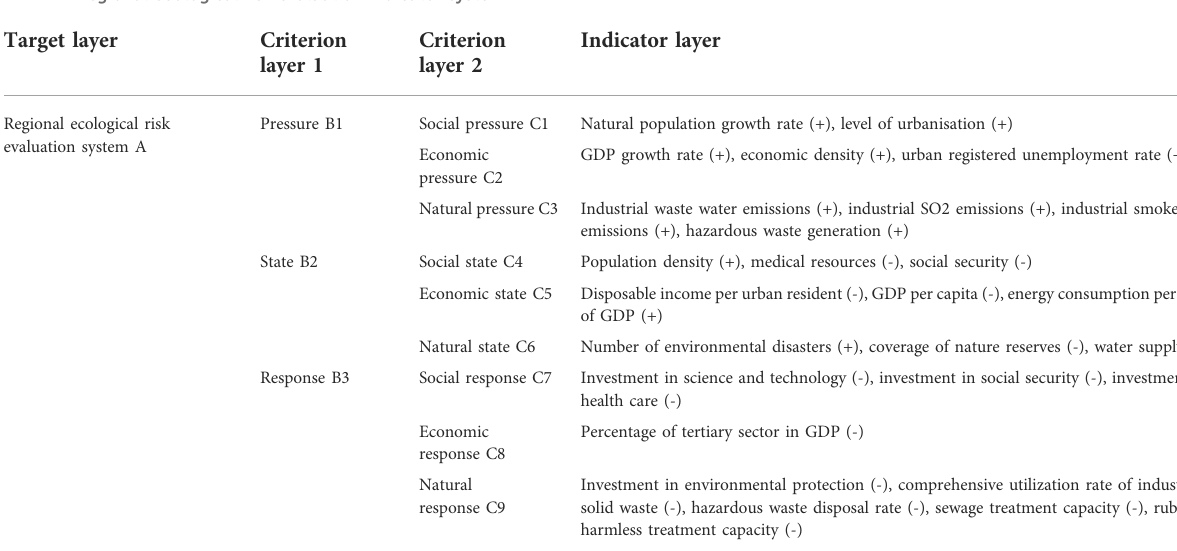
TABLE 1 Regional ecological risk evaluation indicator